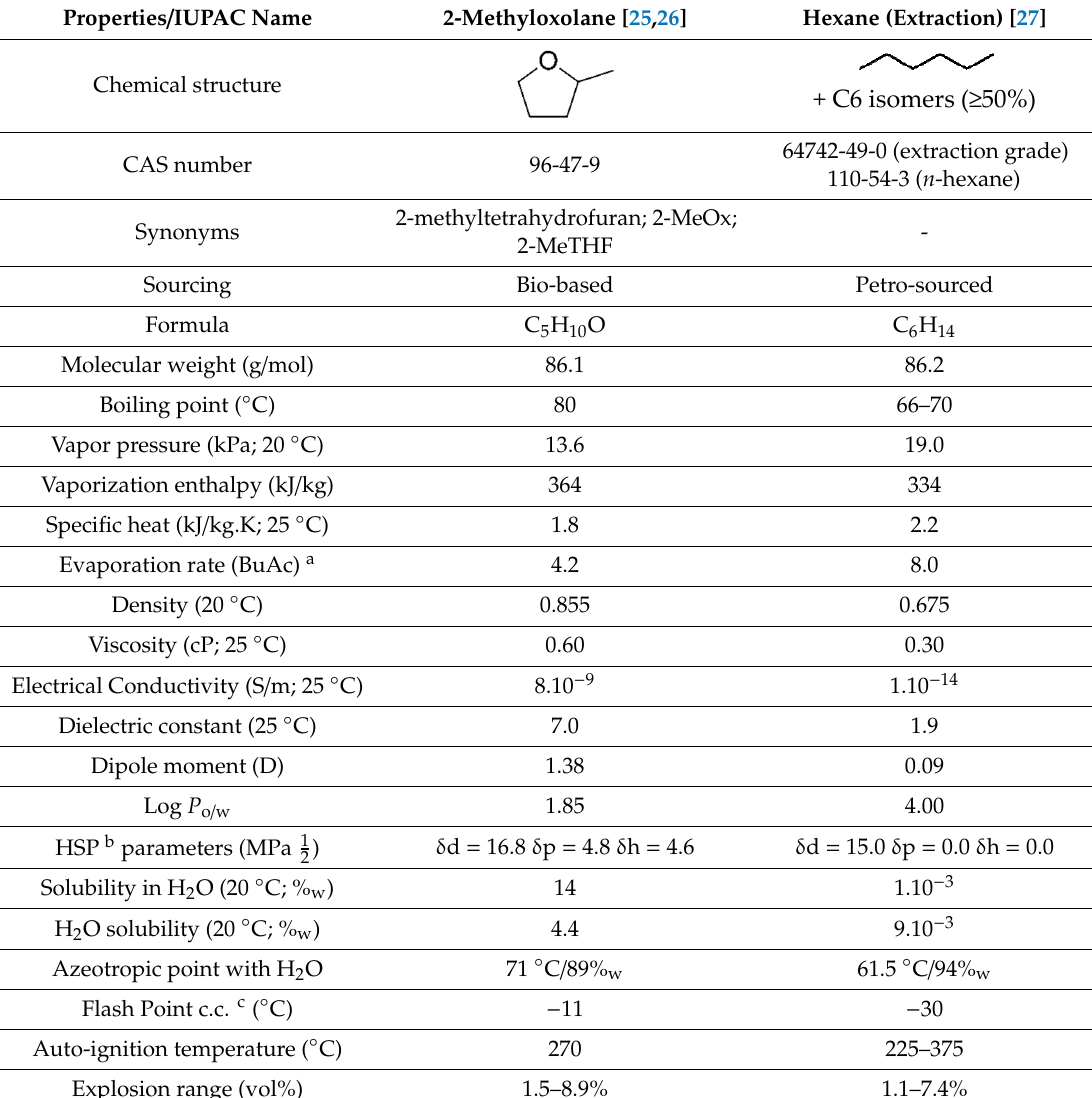
Table 1. Solvent properties of 2-MeOx vs hexane.